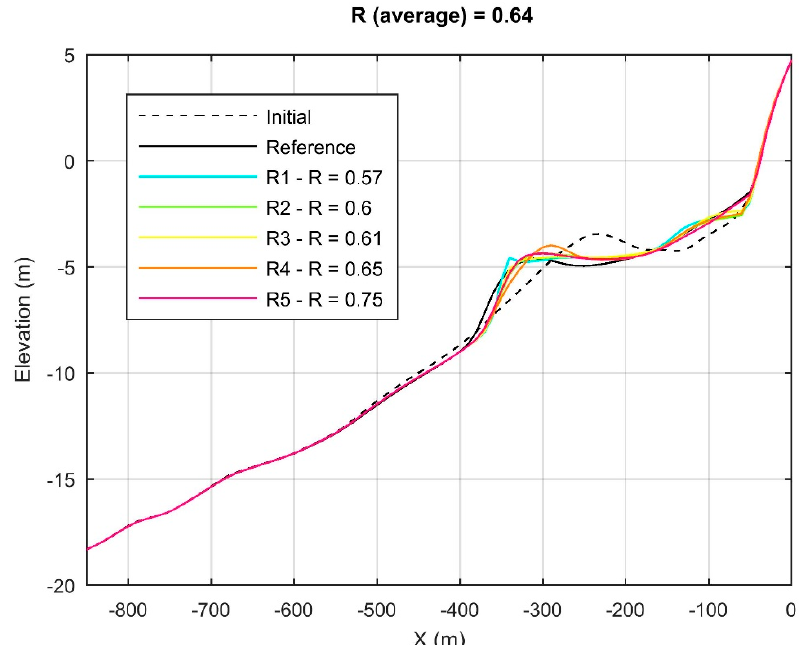
Figure 10. Initial and final profiles with the reduced wave climate of the SBM, random sequencing, k = 12 and T wc = 98 days. The black lines are the initial (dashed) and final (solid) profiles from the brute force model. The colored lines are the final profiles of each random sequence.